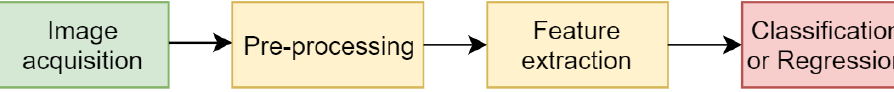
Figure 1. Conventional FER system